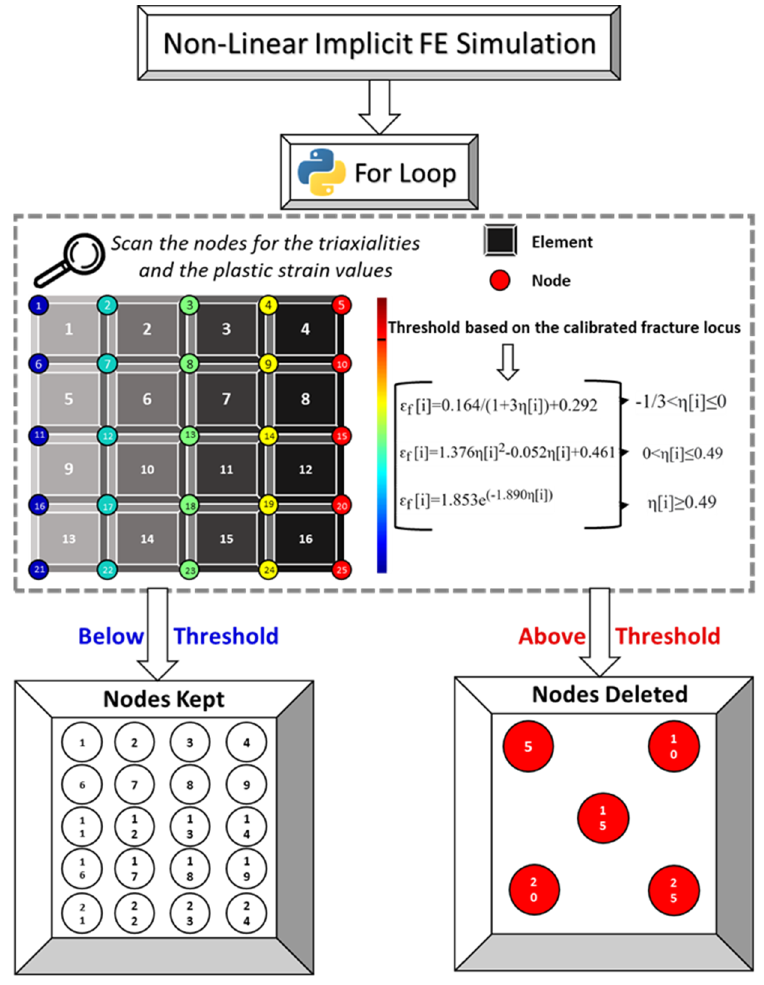
Figure 2. Simplified illustration of the initial part of the code. Dividing the nodes (25 nodes in this example) into two groups (kept and deleted) based on their calculated equivalent plastic strain values compared against the implemented fracture locus of the material used.